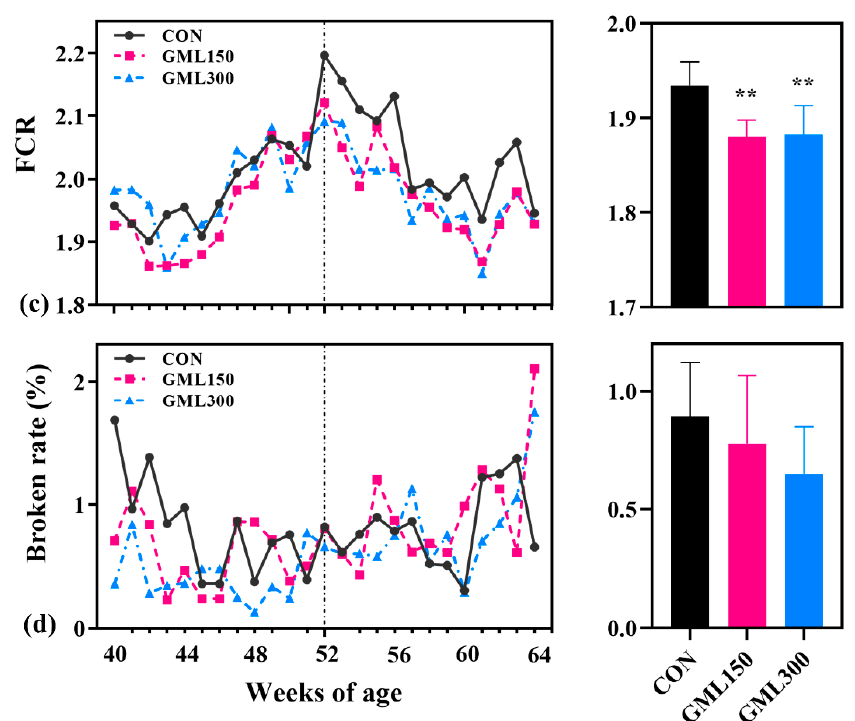
Figure 1. Effect of dietary GML on productive performance during 40-64 weeks of age. ( a ) Laying rate; ( b ) egg weight; ( c ) feed conversion rate (FCR) and ( d ) broken rate. All data were expressed as means ± SD ( n = 6). Asterisk indicates significantly differences according to ANOVA (* p < 0.05, ** p < 0.01).